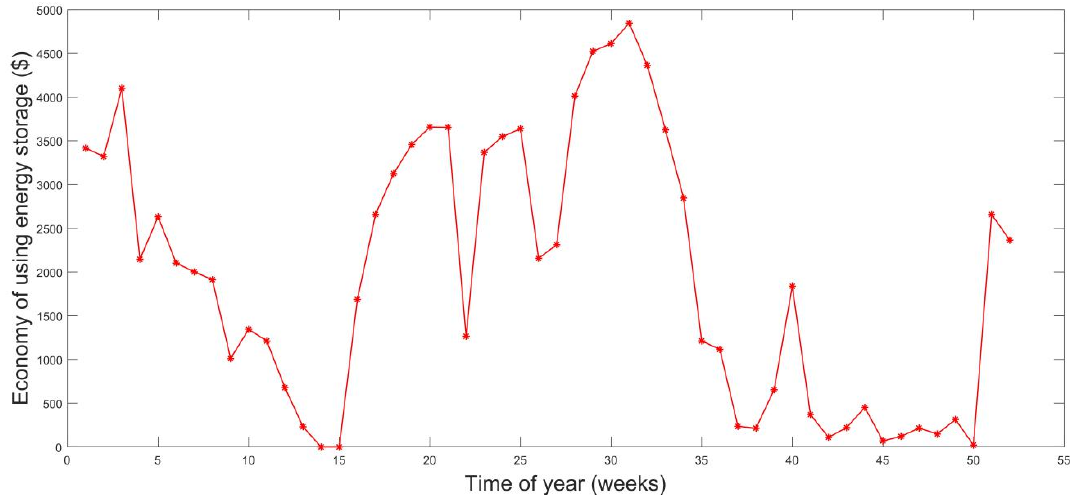
Figure 10. Economy of using energy storage over one year.